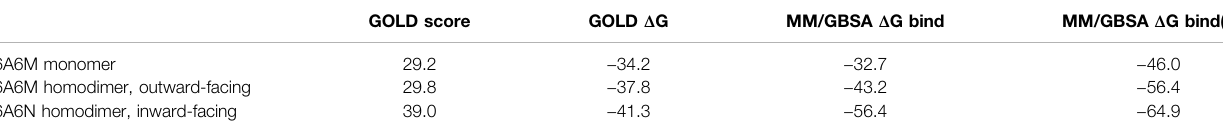
TABLE 2 | Energies for itraconazole binding to P-gp (all values in